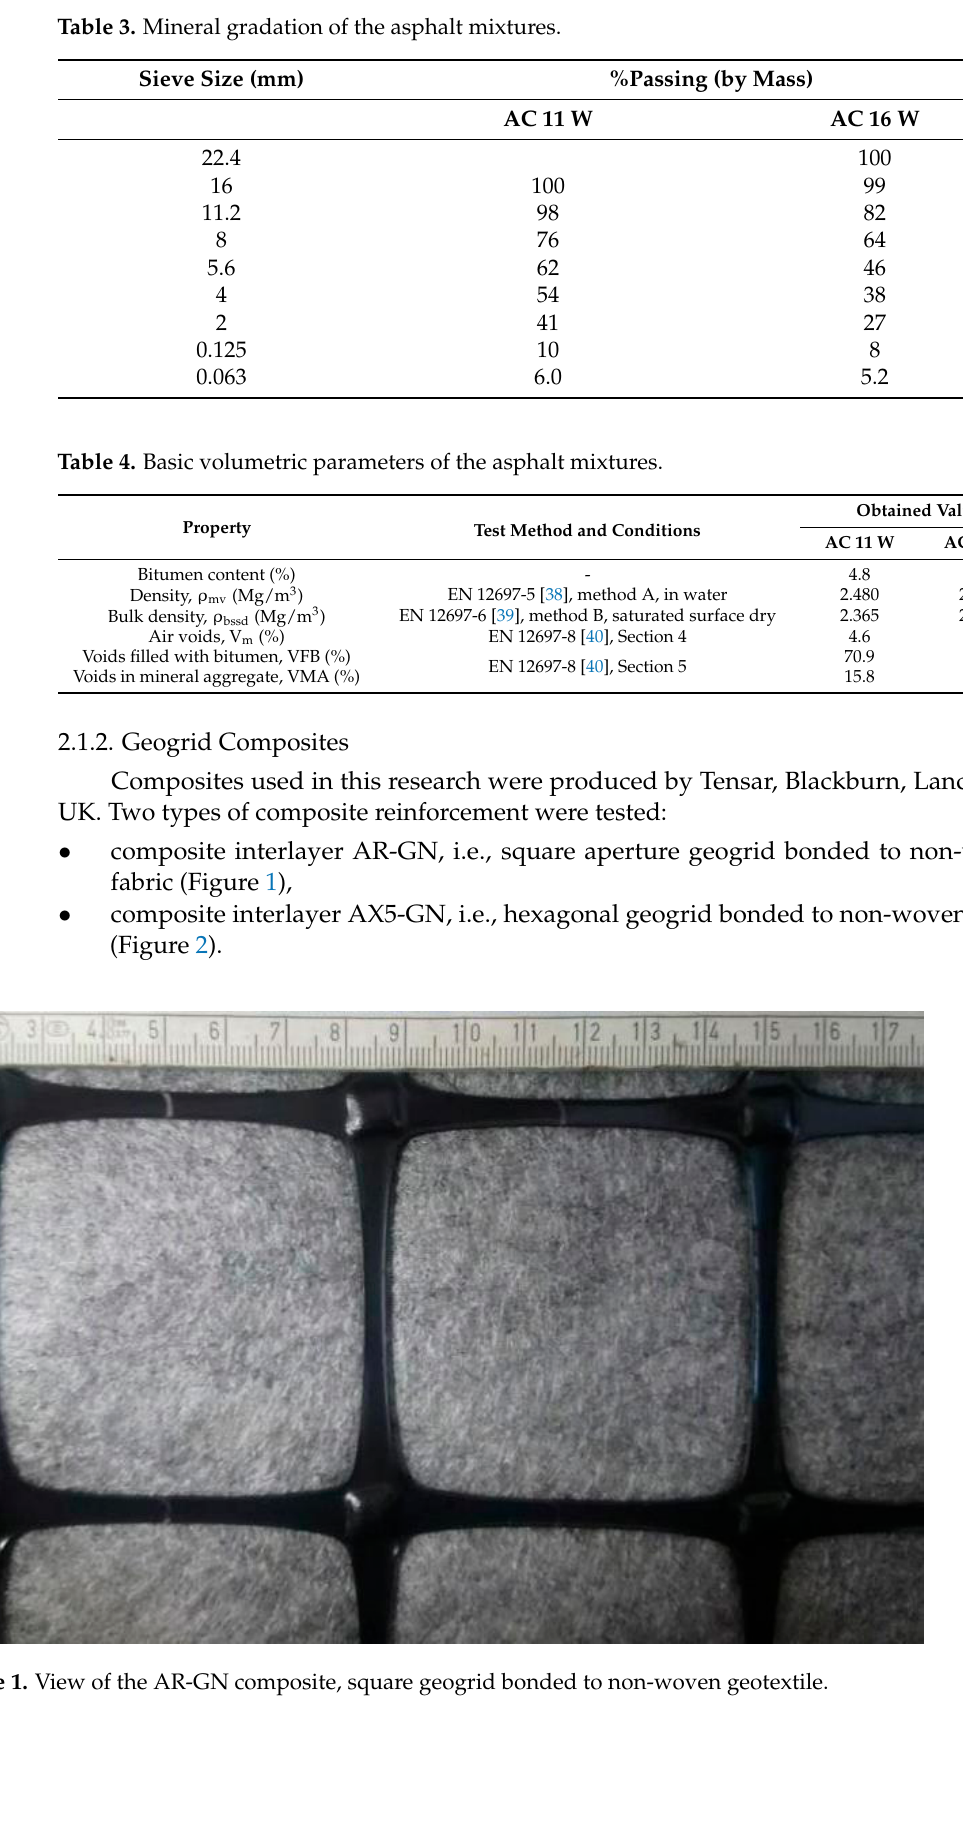
Figure 2. View of the AX5-GN composite, hexagonal geogrid bonded to non-woven geotextile.